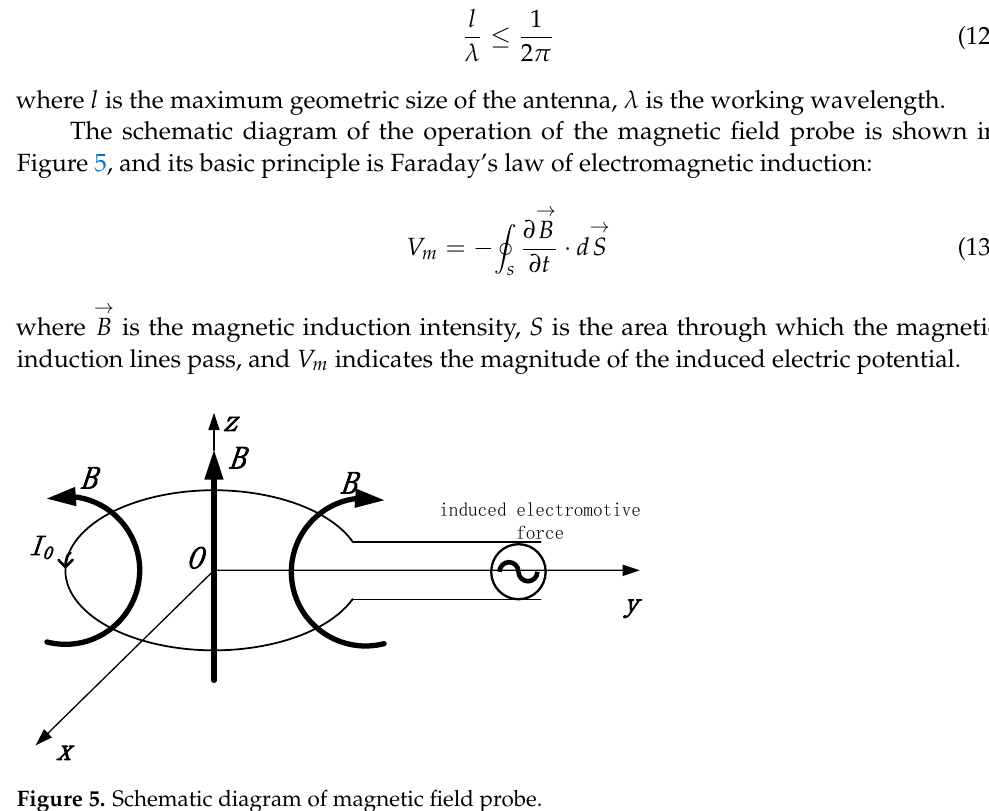
Figure 5. Schematic diagram of magnetic field probe.